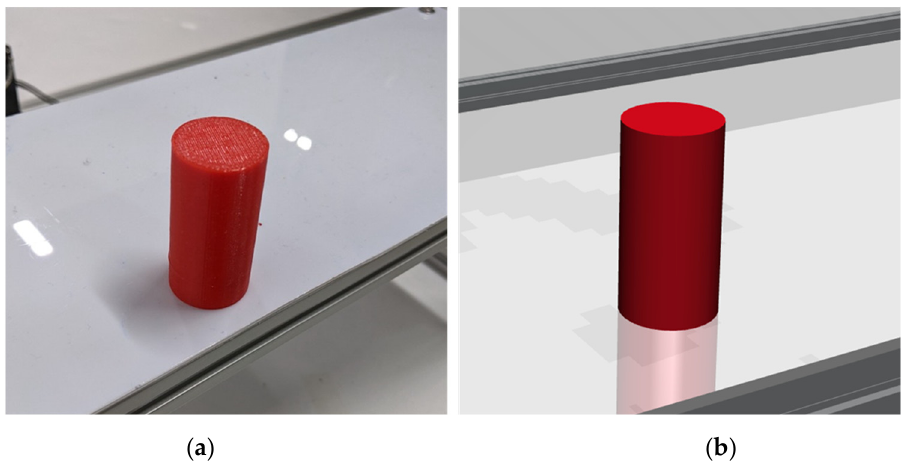
Figure 3. Grasping object used in the actual machine and simulated environment. ( a ) 3D printed target object. ( b ) Virtual target object.